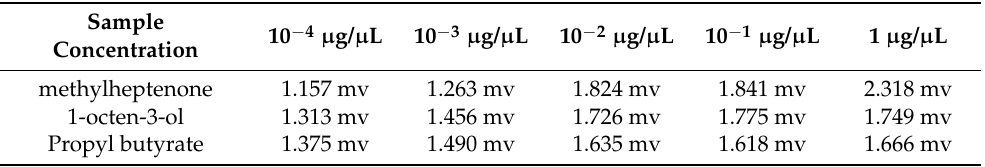
Table 5. EAG relative response value of female W. magnifica to different concentrations of three compounds.